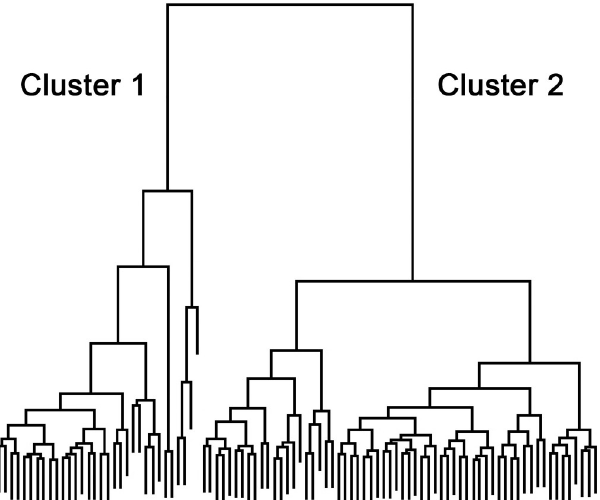
Fig 2. Hierarchical cluster analysis. Nine variables—age, HTN, DM, BMI, volume at first uninhibited detrusor contraction, number of uninhibited contractions during filling, BOOI, BCI, and bladder Power at maximum flow– were used for cluster analysis.